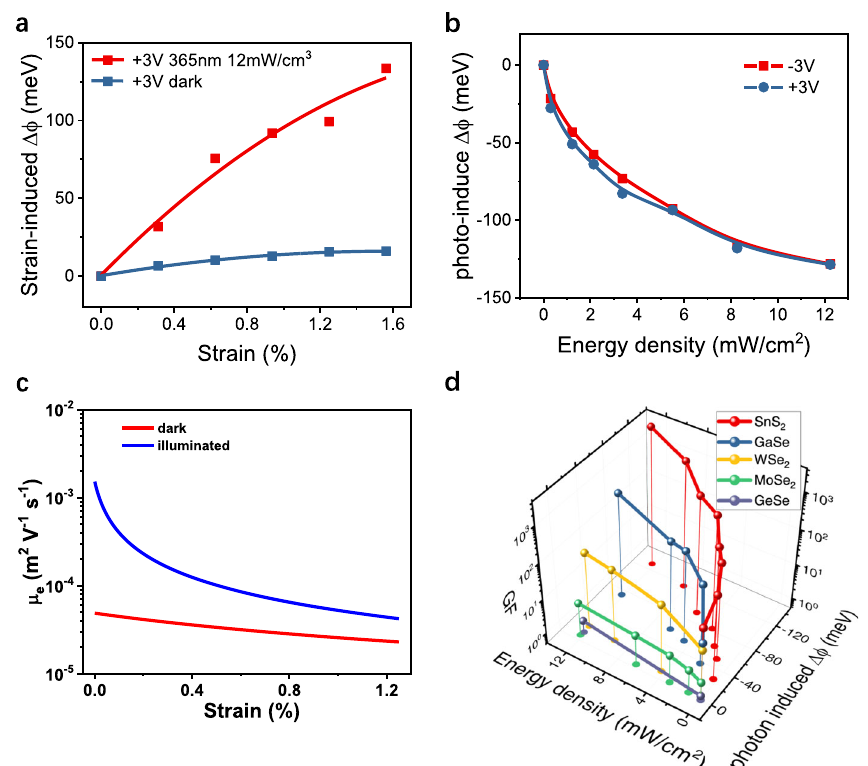
Fig. 2 Origin of enhanced GF value by photo illumination. a Calculated relative change of equivalent potential variation ( Δ ϕ ) of the SnS 2 based strain sensor with strain ( s ) with and without external illumination. b Calculated relative change of Δ ϕ at zero strain ( s ) as a function of power density of illumination. c Calculated mobility as a function of strain in darkness (red line) and under 365 nm laser illumination (blue line). d Demonstration of the universality of GF enhancement phenomenon by photo illumination for Van der Waals semiconducting materials including SnS 2 , GaSe, GeSe, monolayer WSe 2 , and monolayer MoSe 2